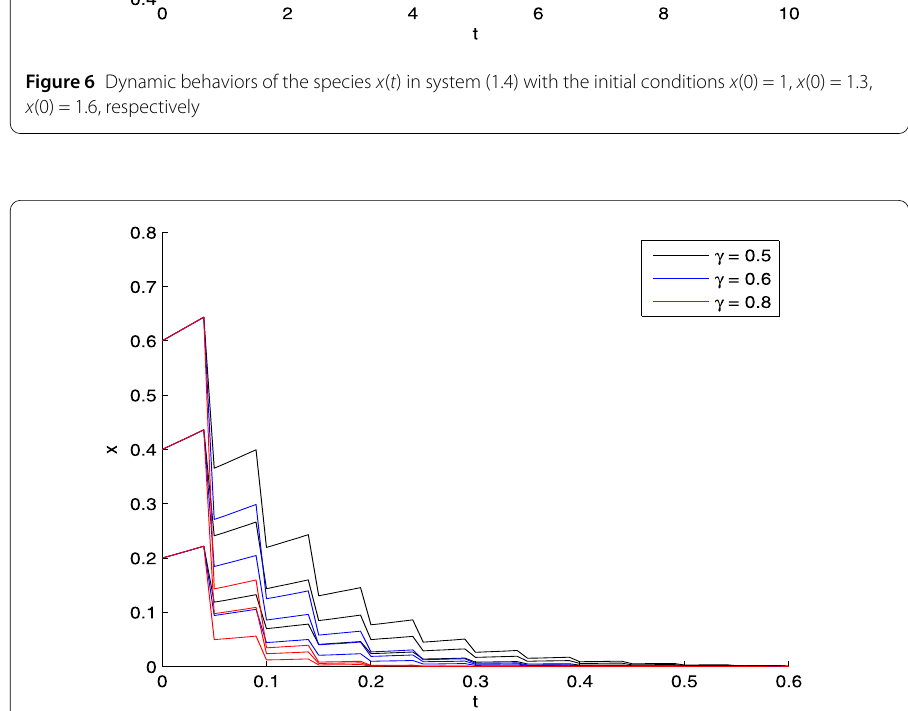
Figure 7 Dynamic behaviors of the species x ( t ) in system (1.4) with the initial conditions x (0) = 0.2, x (0) = 0.4, x (0) = 0.6, respectively